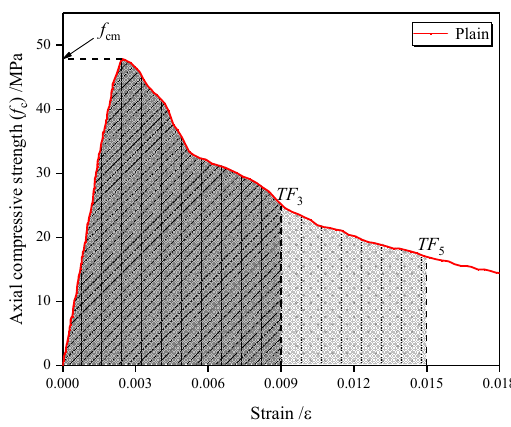
Figure 16. Schematic representation of toughness.